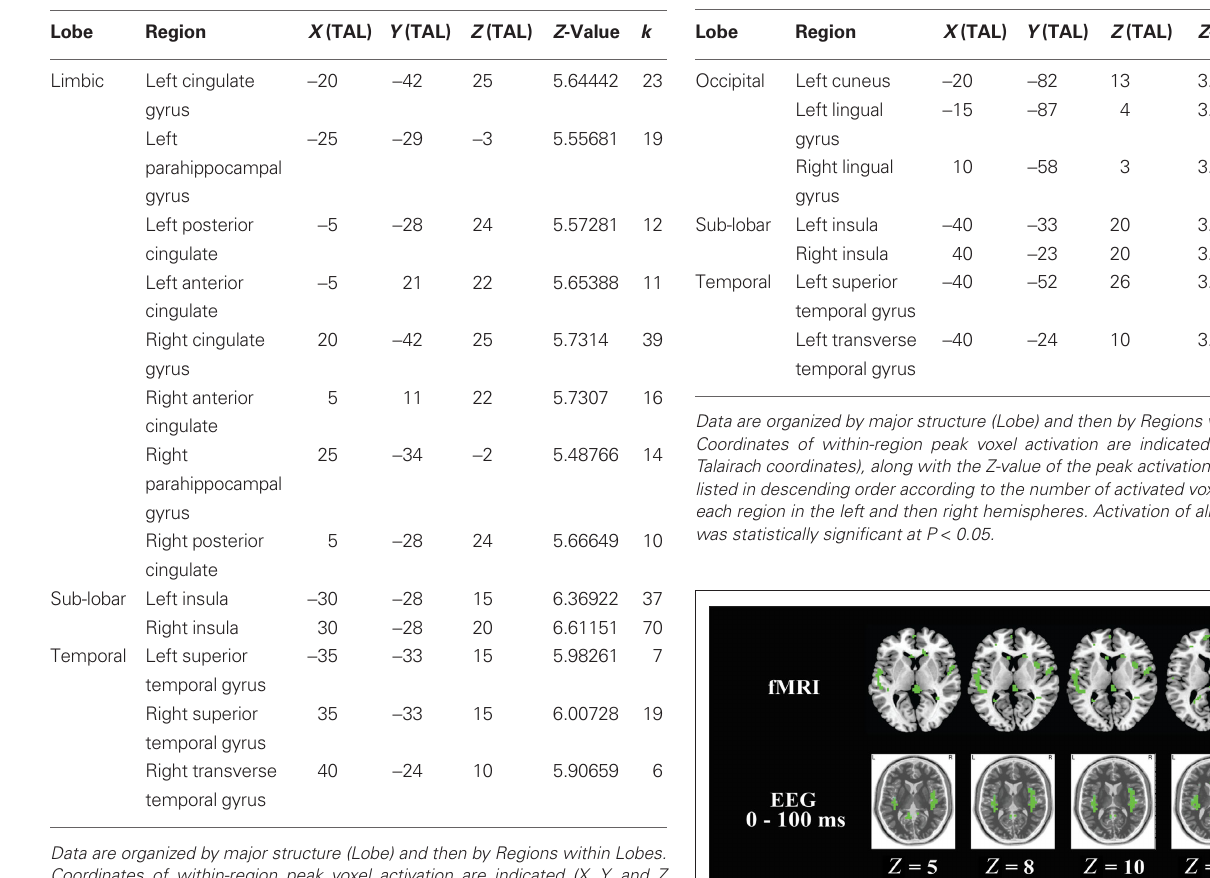
Table 4 | Electroencephalography activation differences specific to